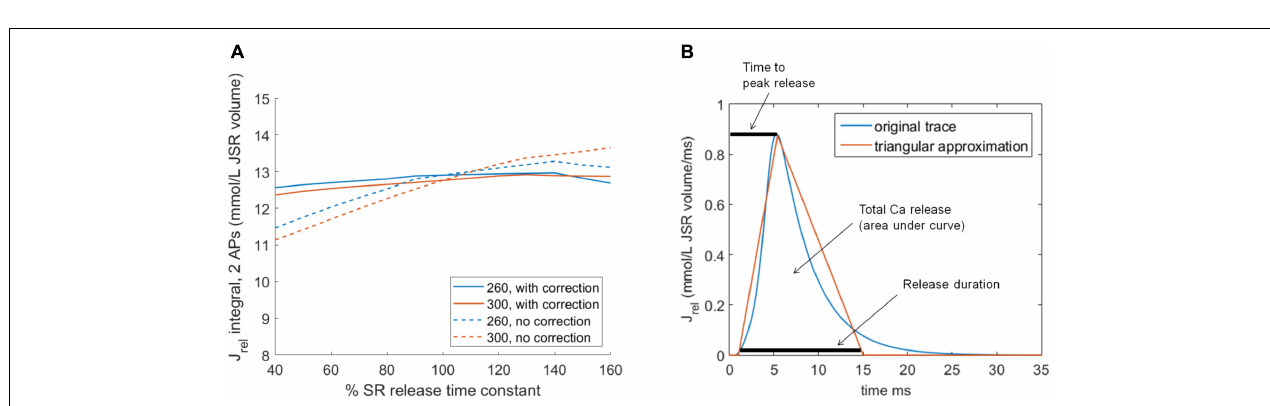
FIGURE 2 | Altering SR release dynamics at bcl 260 and 300 in the HeRd model: (A) The relationship between altered time constant of RyR release and total amount of calcium released over two consecutive action potentials at two pacing rates. In solid lines is shown the relationship after the application of compensatory rescaling of I CaL conductance, as described in the main manuscript. The dashed lines show how the relationship between altered SR release time constant and total calcium release would have looked without such scaling. (B) An illustration of the approximation of native HeRd J rel using a triangle. Throughout the article, parameters varied are the release duration, time to peak release, and total calcium